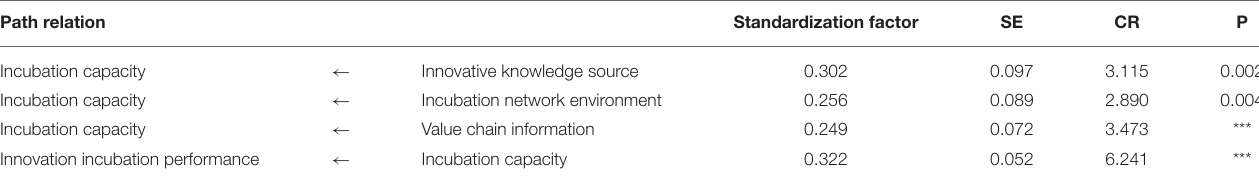
TABLE 4 | Path coefficients.